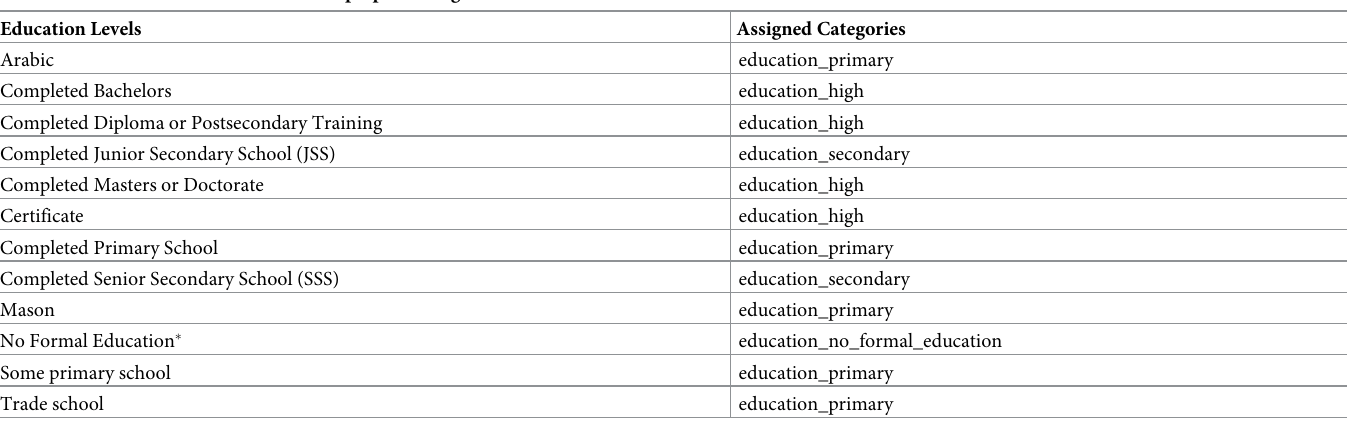
Table 2. Education levels before and after